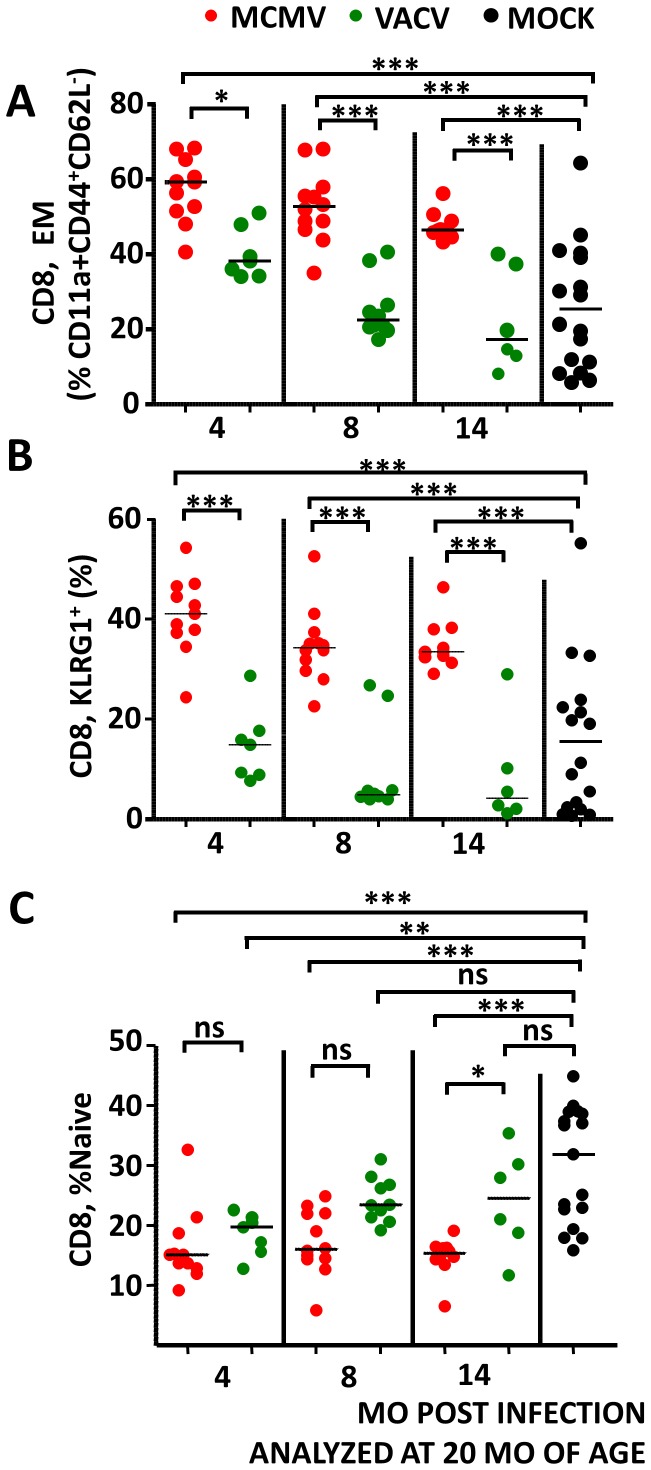
Long-term maintenance of effector and decrease of naïve CD8 subsets upon MCMV infection.Mouse littermates were infected at 6, 12 or 16 months of age with MCMV (red symbols) or VACV-IE1 (green symbols) and compared at 20 months of age (4, 8 or 14 months post infection, as indicated below x axes) to uninfected controls (black symbols). (A) CD8+ cells were gated on CD11a+CD44+, then on a CD62L− gate, and frequencies of CD11a+CD44+CD62L− cells in the CD8 pool were calculated. Each symbol represents a mouse, horizontal lines indicate medians. (B) CD8+ cells from mice shown in panel A were gated on a KLRG1+ gate, and their frequency in individual mice is shown. Each symbol represents a mouse, horizontal lines indicate medians. Significance was assessed by ANOVA followed by Bonferroni post-analysis for indicated columns (* - p<0.05, *** - p<0.001). (C) Naïve cells were defined by progressive gating on a CD11a−CD44−, and then on a CD127+CD62L+ gate (see Fig. S2). Each symbol represents a mouse, horizontal lines indicate medians. Significance was assessed by ANOVA followed by Bonferroni post-analysis for indicated columns (ns – p>0.05, * - p<0.05, ** - p<0.01, *** - p<0.001).